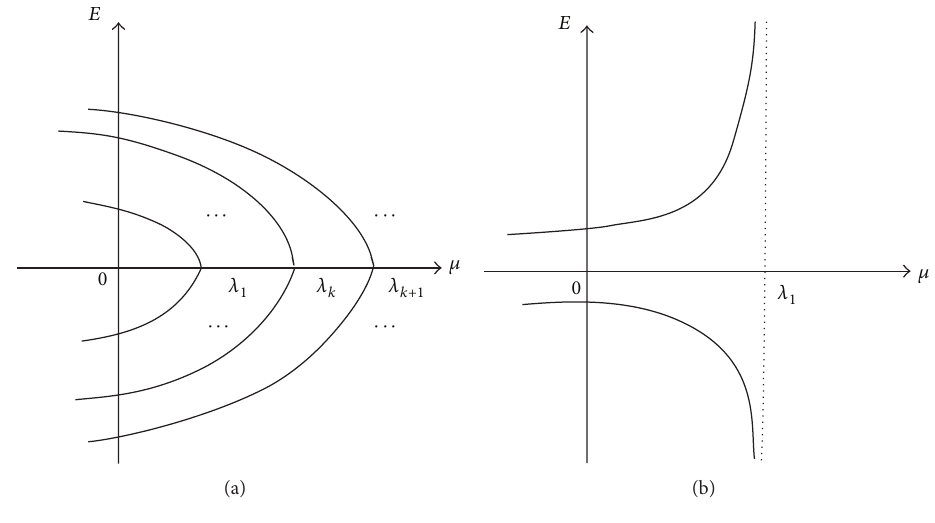
Figure 1: The bifurcation diagrams of solutions of